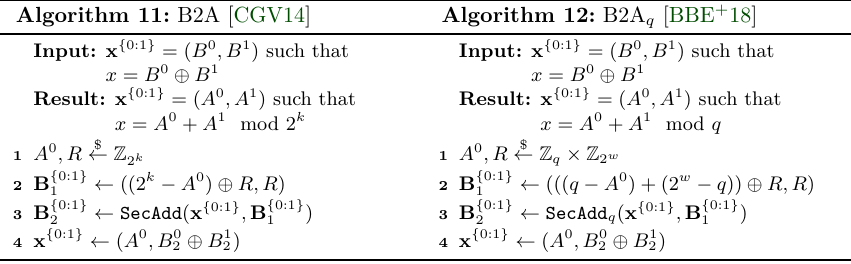
Algorithm 11: B2A [CGV14] Algorithm 12: B2A q [BBE +